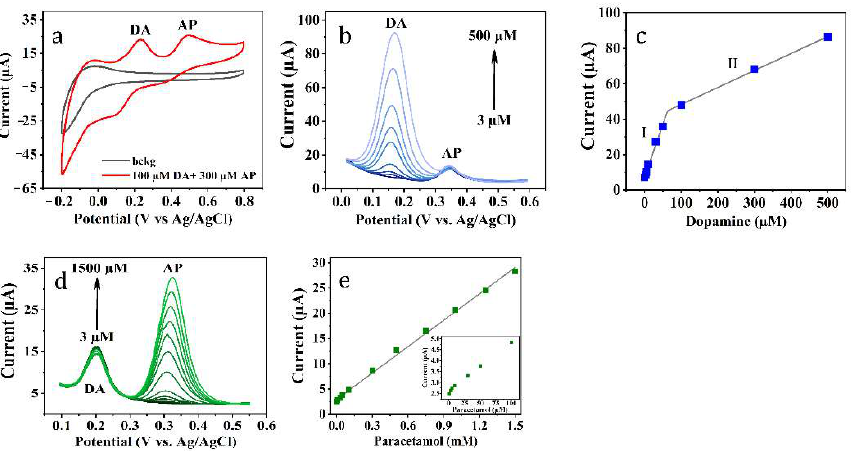
Figure 7. ( a ) CV of disodium di- o -phthalatocuprate–based electrode in background electrolyte and in presence of DA and AP; ( b ) DPVs of I/GCE recorded in mixture containing 50 µ M AP with different concentrations of DA; ( d ) 20 µ M DA with different concentrations of AP; the linear relationship between peak currents and the concentrations of ( c ) DA and ( e )AP.